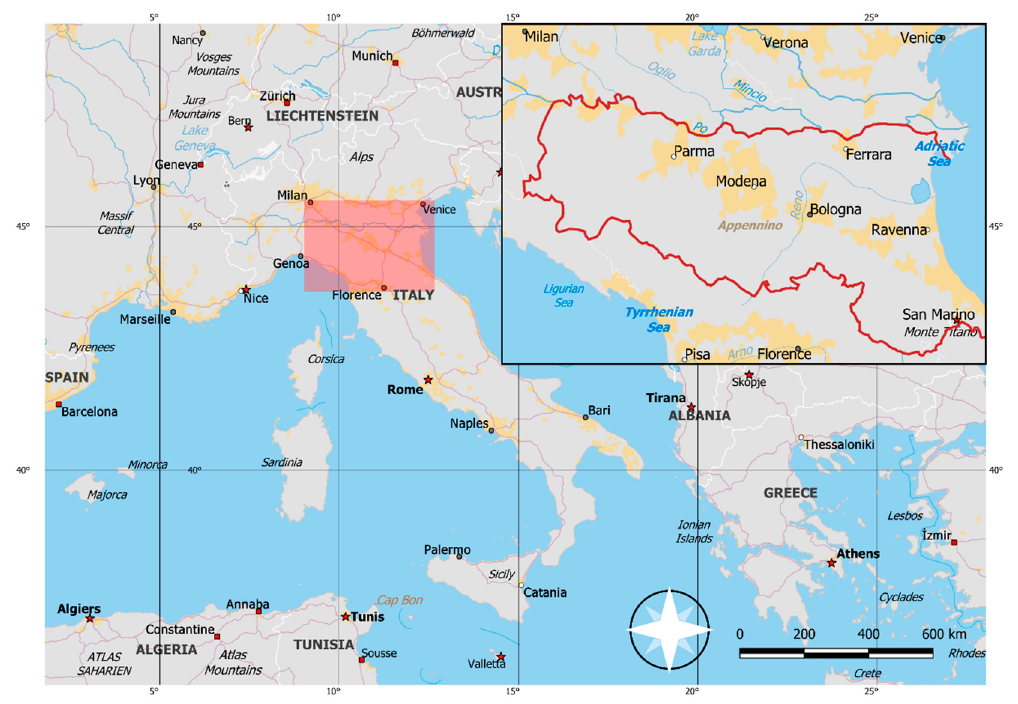
Figure 1. The study area. The Emilia-Romagna region is highlighted in red. Map created using Natural Earth Data in QGIS (v. 3.10).